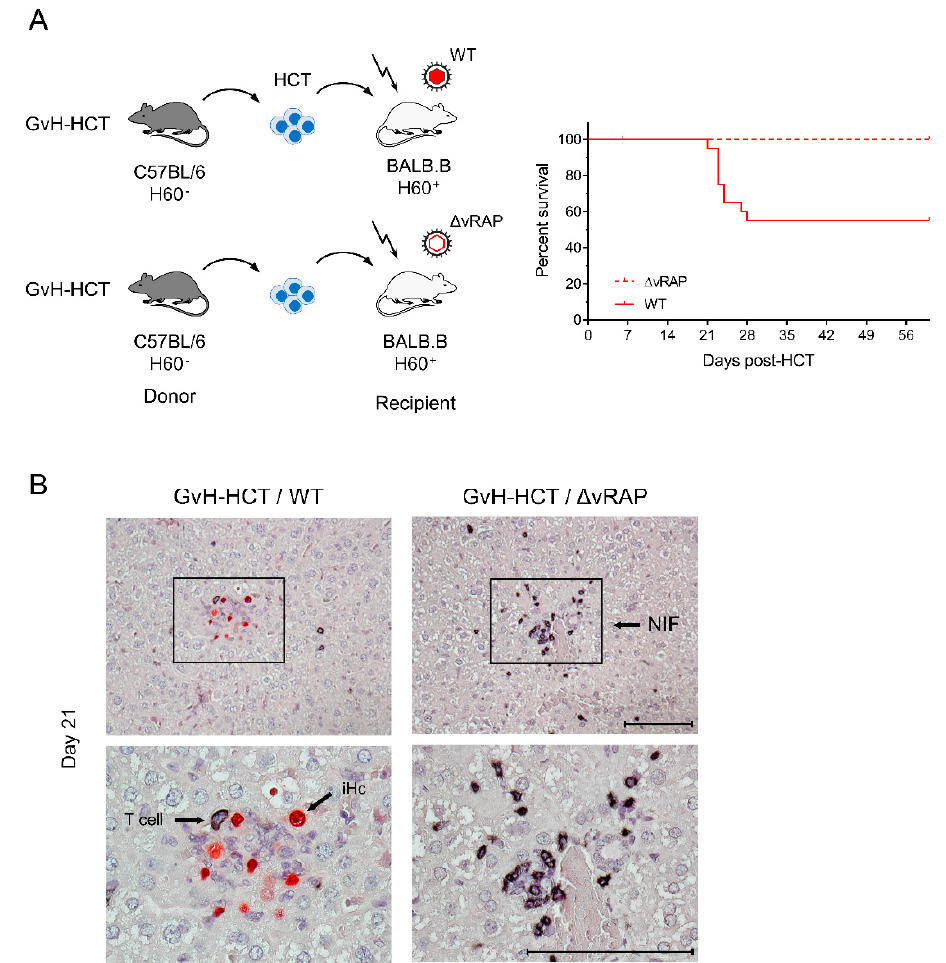
Figure 3. Comparison of lethality and viral histopathology in minor-HAg H60-mismatched GvH-HCT recipients infected with wild-type (WT) mCMV or a mutant of mCMV deleted for the genes that code for immunoevasive “viral regulators of antigen presentation” ( Δ vRAP). ( A ) Model and Kaplan–Meier survival curves. The flash symbol indicates hematoablative total-body γ -irradiation. ( B ) 2-color immunohistological images of liver tissue sections (upper panels, overview; lower panels, resolved to greater detail) showing tissue infiltration by T cells (black staining) and infected hepatocytes (iHC, red staining). Frames demarcate regions resolved to greater detail in the corresponding lower panel images. NIF, nodular inflammatory focus. Bar markers: 100 µ m. Reproduced from reference [43] in new